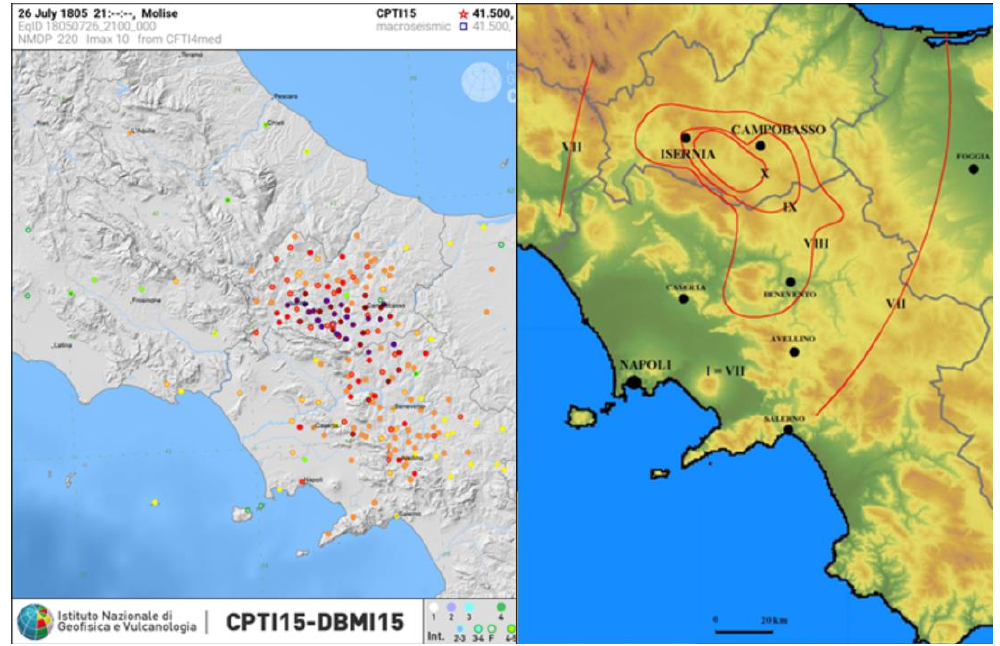
Figure 7. Map of the 1805 MCS macroseismic intensity (modified from [1]) on the left; isoseismal map of the 1805 Bojano earthquake (modified from [50]) on the right.